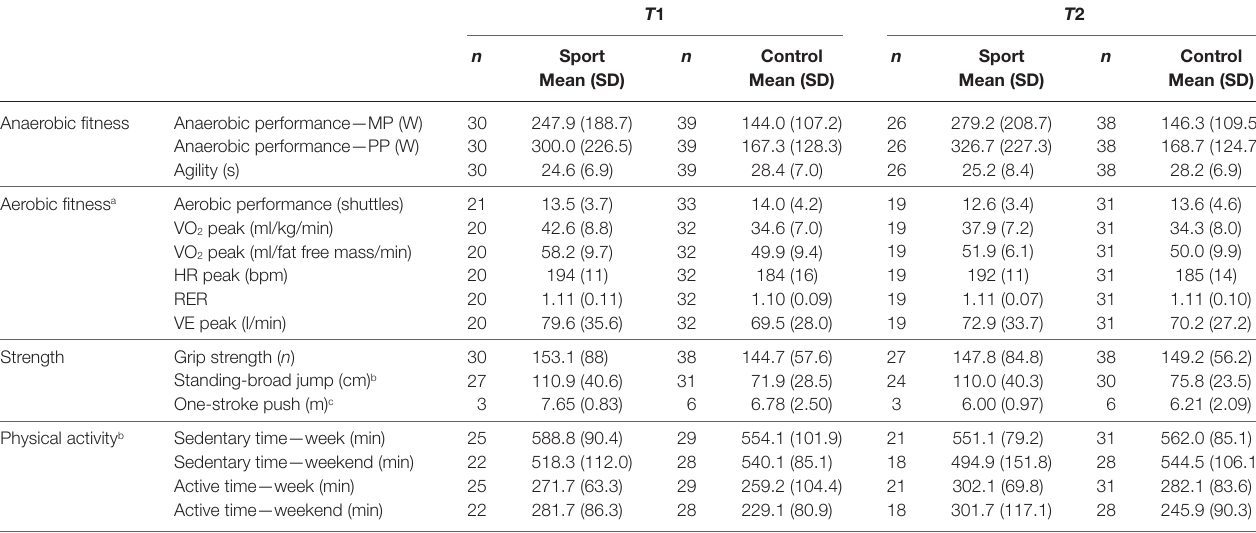
TaBlE 2 | Mean (SD) of physical fitness and physical activity before ( T 1) and after ( T 2) the school-based sports program.